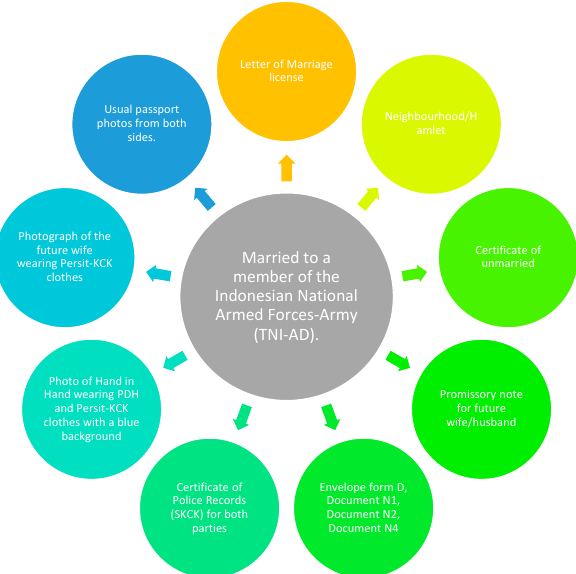
Figure 3. Requirements to become Persit-KCK members. Source: processed from various sources, 2022.